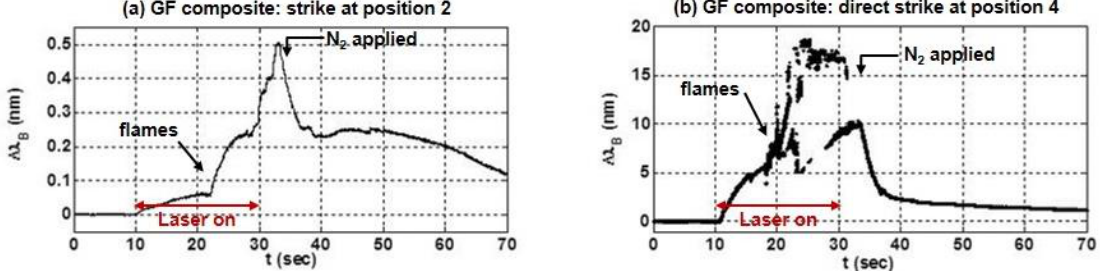
Figure 6. The variation in the 1550-nm sensor in the GF composite during laser strikes at ( a ) position 2 and ( b ) position 4.